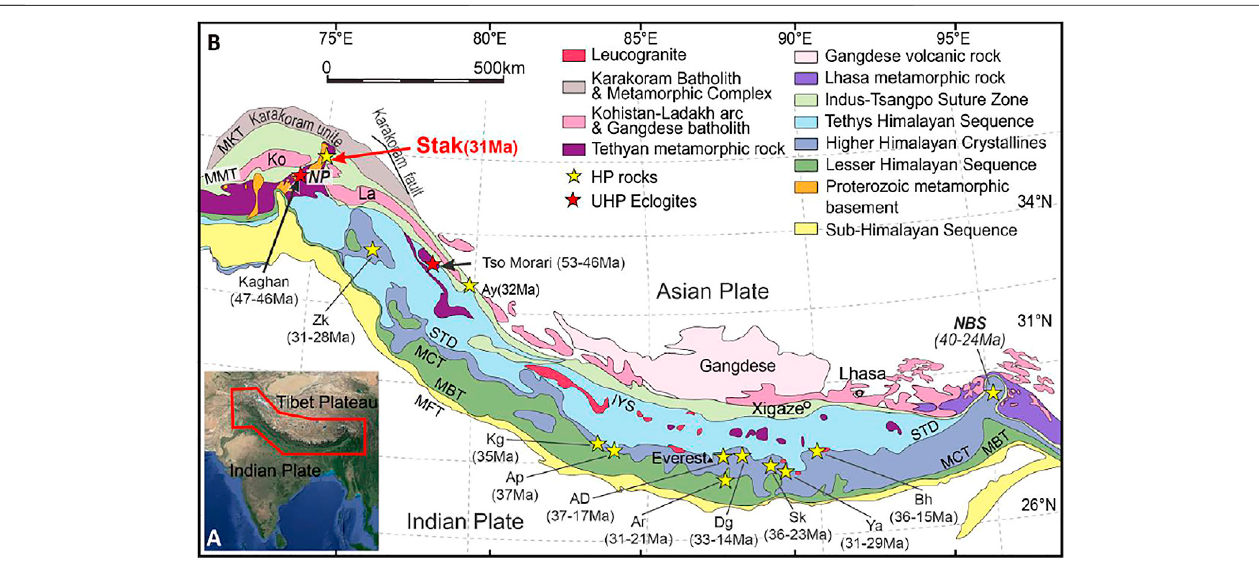
FIGURE 1 | (A) Location of the Himalayan orogen. (B) Geological map of Himalaya (modi fi ed after Ding et al., 2016a; Guillot et al., 2008) with locations and peak metamorphic ages of high-pressure (HP) and ultrahigh-pressure (UHP) metamorphic rocks. MKT, Main Karakoram Thrust; MMT, Main Mantle Thrust; IYS, Indus – Yarlung Suture; STD, South Tibetan Detachment; MCT, Main Central Thrust; MBT, Main Boundary Thrust; MFT, Main Frontal Thrust; AD, Ama Drime; Ap, Annapurna; Ar, Arun; Ay, Ayilari; Bh, Bhutan; Dg, Dinggye; Kg, Kali Gandaki; Ko, Kohistan arc unite; La, Ladakh arc unite; NBS, Namche Barwa Syntaxis; NPS, Nanga Parbat Syntaxis; Sk, Sikkim; Ya, Yadong; Zk, Zanskar. Detailed age data and sources are listed in Supplementary Table S6